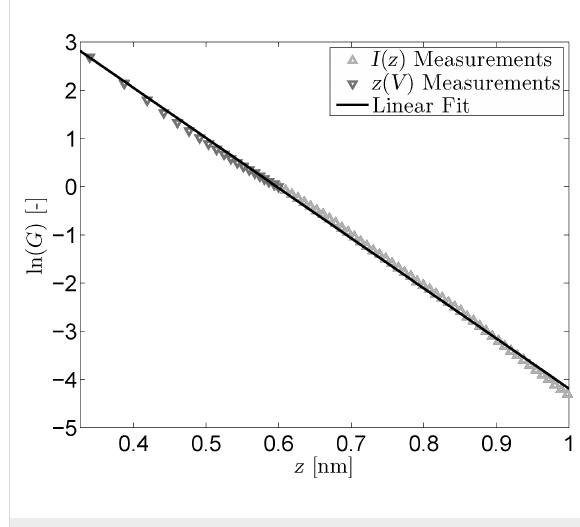
Figure 6: Combined logarithmic conductance versus tip–sample dis- tance for z ( V ) and I ( z ) measurements. Logarithmic offsets for both types of measurements were zeroed at z 0 = 0.6 nm. The linear fit has a slope of − 10.4 nm − 1